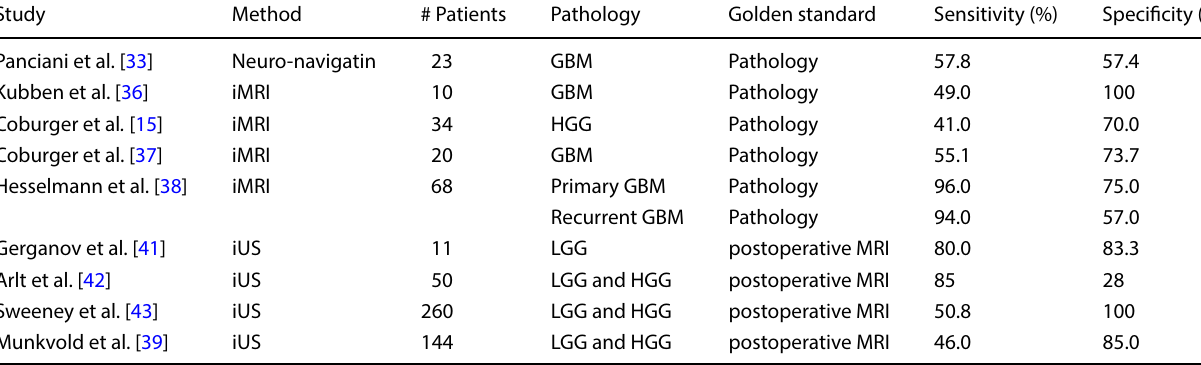
Table 2 Studies investigating diagnostic accuracy of intraoperative image guidance in brain